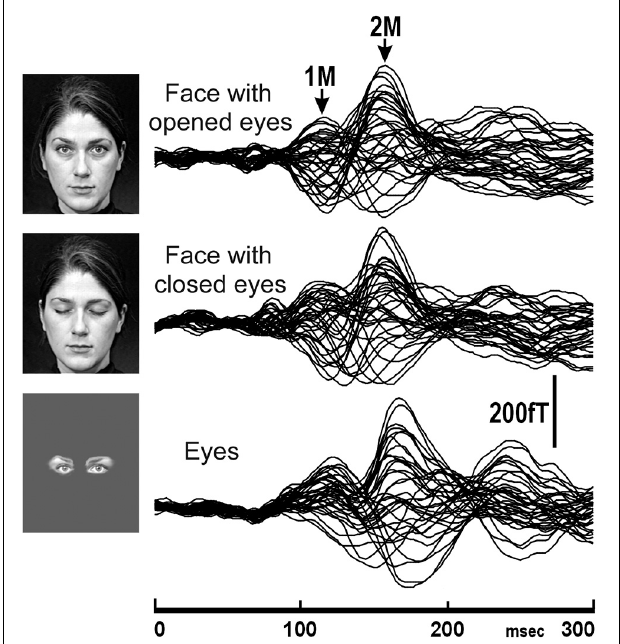
FIGURE 1 | The MEG waveforms of a representative subject in response to the presentation of stimuli, face with opened eyes, face with closed eyes, and eyes recorded from the right hemisphere. The MEG waveforms recorded from 37 channels are superimposed [adopted from Watanabe et al. (1999b)]. MEG,